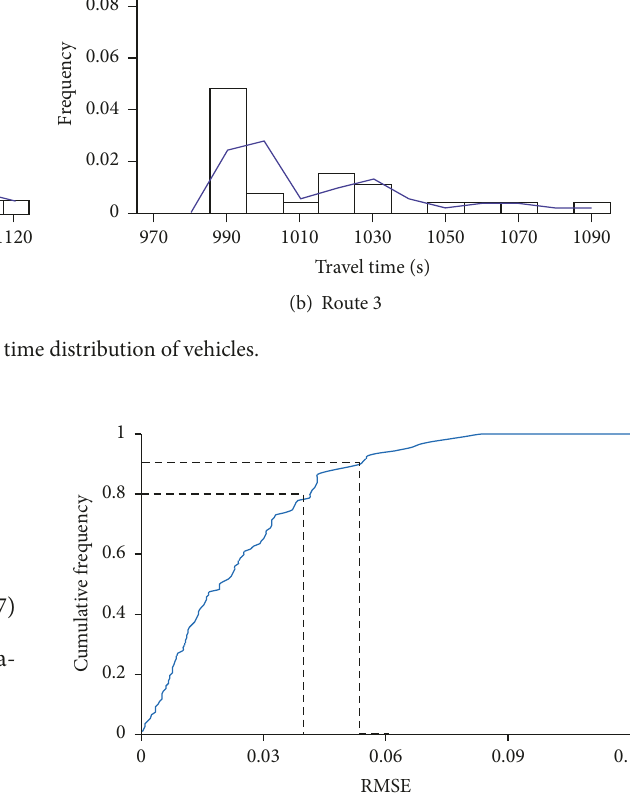
Figure 7: Cumulative probability distribution curve of RMSE.